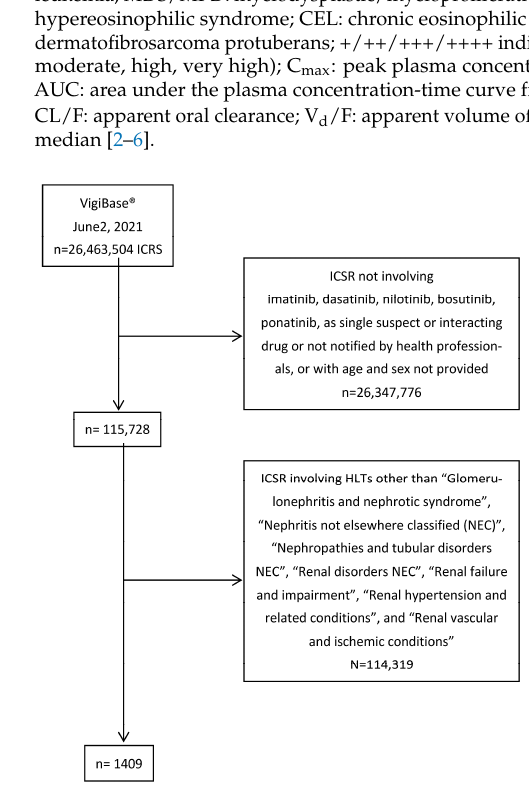
Figure A1. Flow chart of the study. Table A2. Reporting odds ratio from standard disproportionality analyses for the selected preferred term (PT).